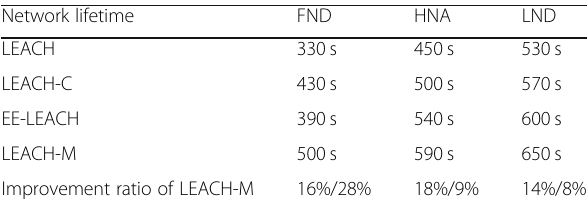
Table 4 The statistics of energy consumption of four algorithms